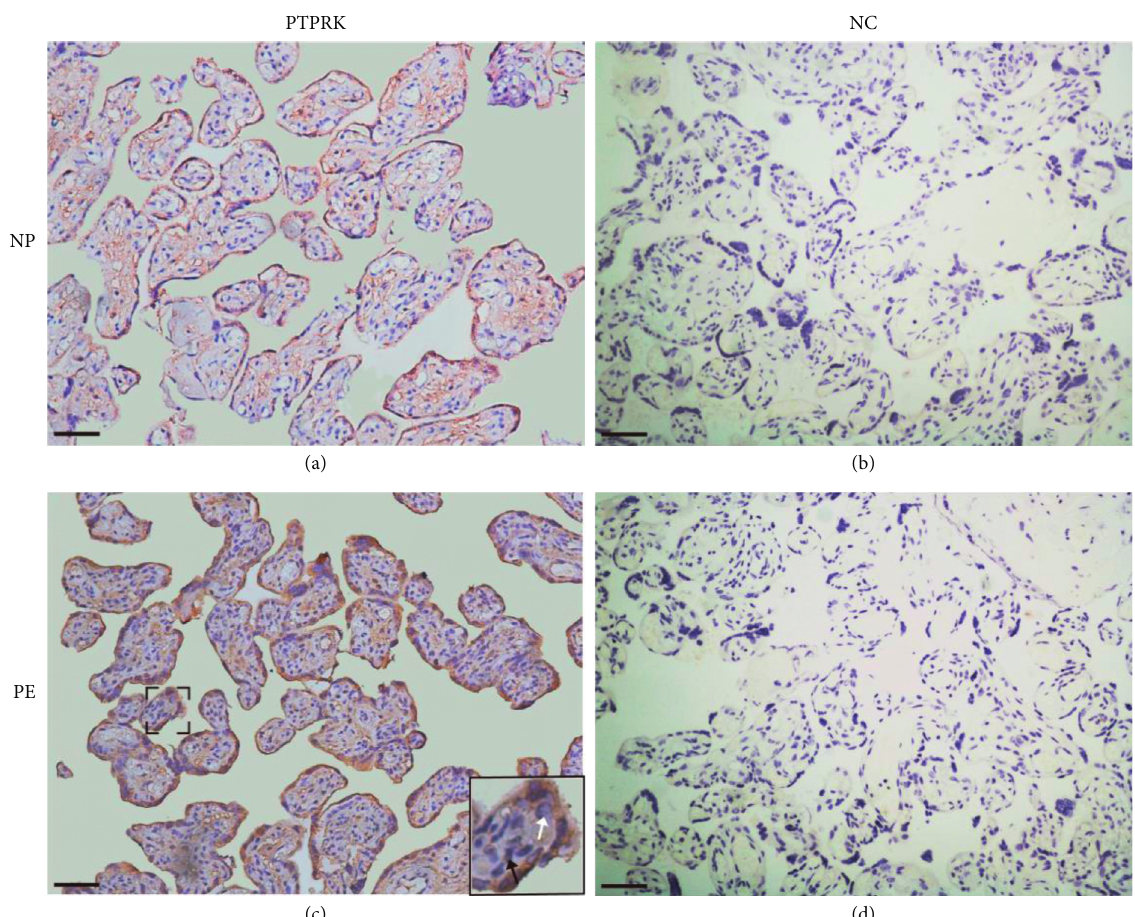
Figure 1: Immunolocalization of PTPRK in human placentas from normal pregnancies (NP) and preeclamptic (PE) pregnancies. (a, c) Brown staining of PTPRK. The tissue sections ( n � 20 placentas for each group) were probed with PTPRK antibodies after hematoxylin counterstaining. (b, d) Negative control (NC). Preimmune IgG controls are shown in the right panel. The white arrow: syncytiotrophoblast. The black arrow: cytotrophoblast. Scale bars, 50 μ